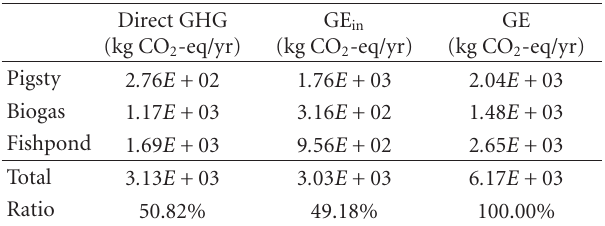
Table 4: GE of the “pig-biogas-fish”